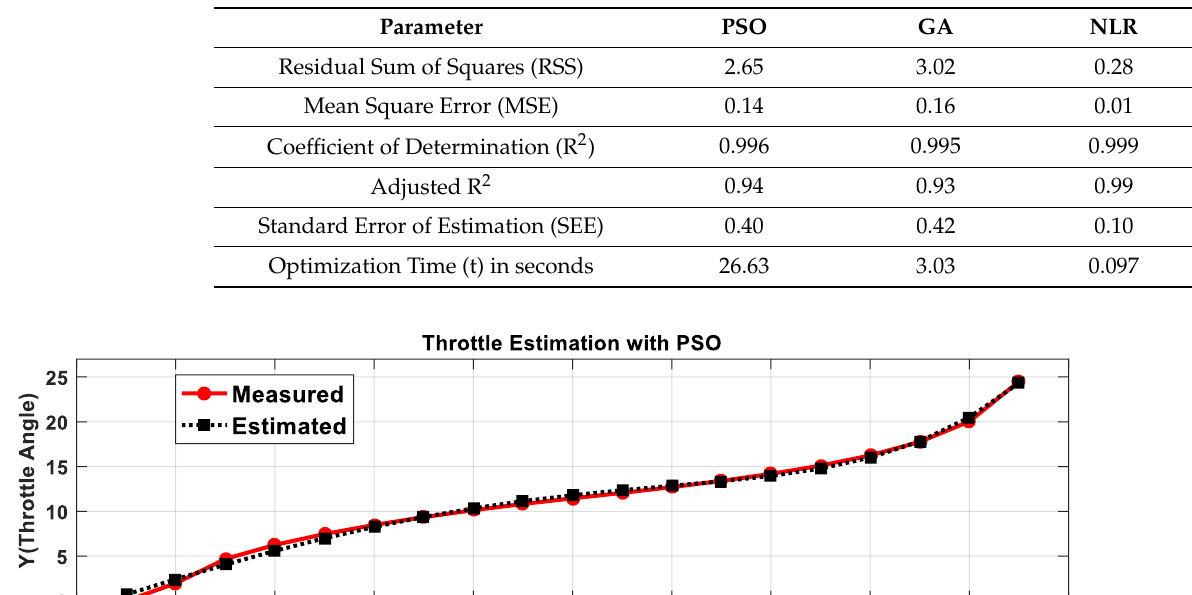
Table 9. Estimation statistics for throttle estimation.